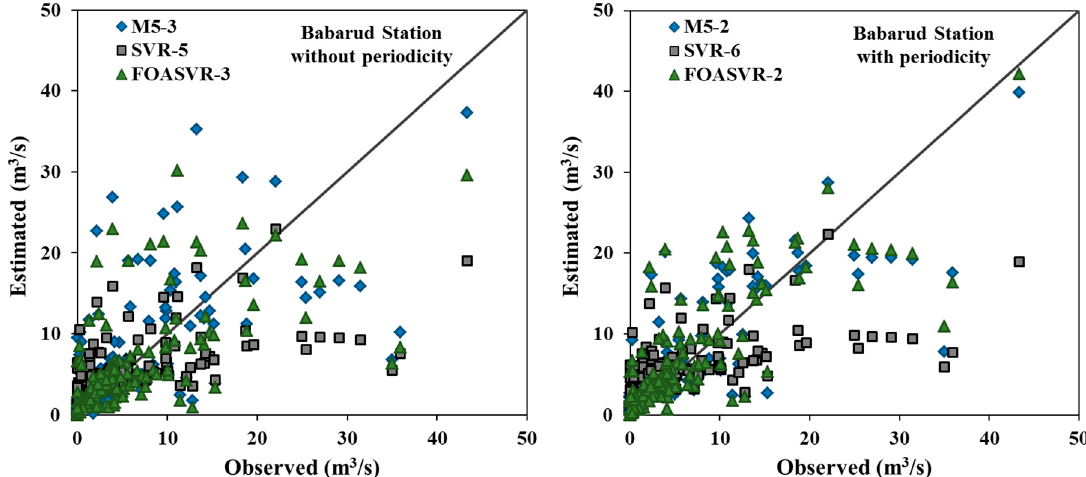
Figure 8. The observed and forecasted monthly river flows for Vaniar station with periodicity.